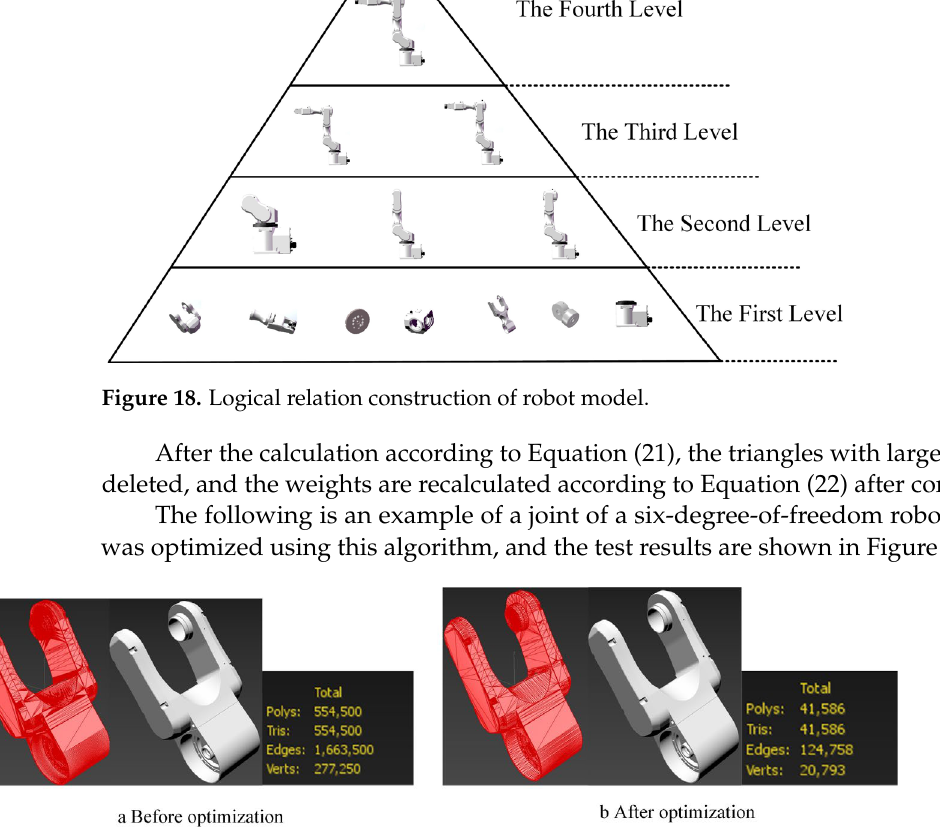
Figure 19. Comparison before and after model optimization.